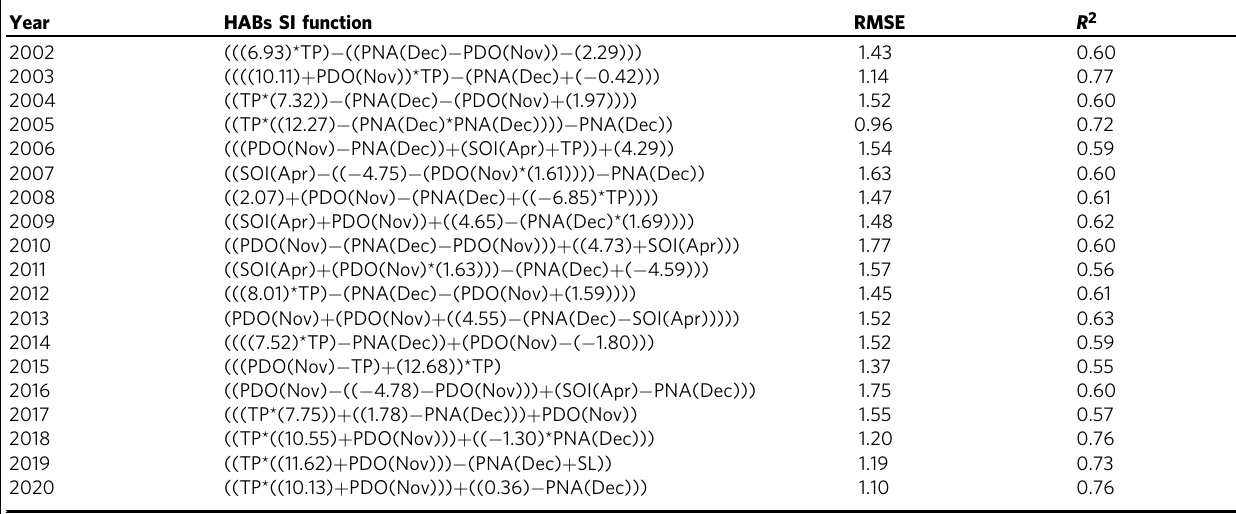
Table 1 Performance (root mean square error (RMSE) and coef fi cient of determination ( R 2 )) of GA-chem-clim (using nutrient loading and climate indices) developed using Genetic Algorithm under the jackknife